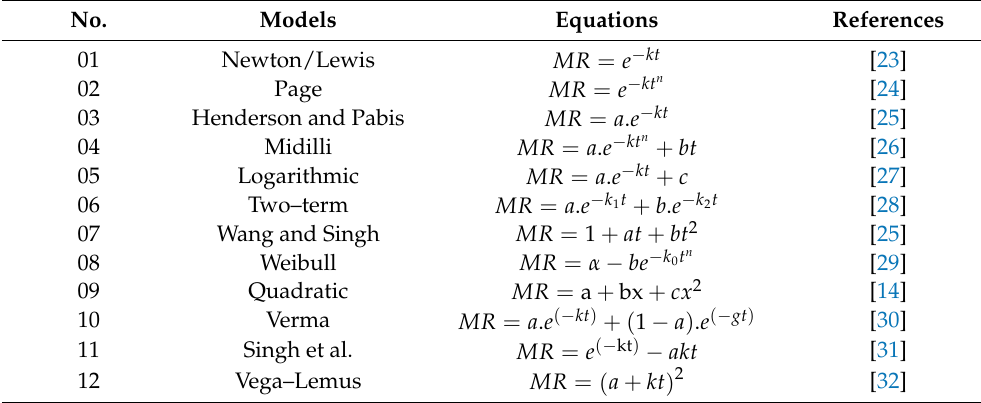
Table 1. Several popular mathematical models were used in this